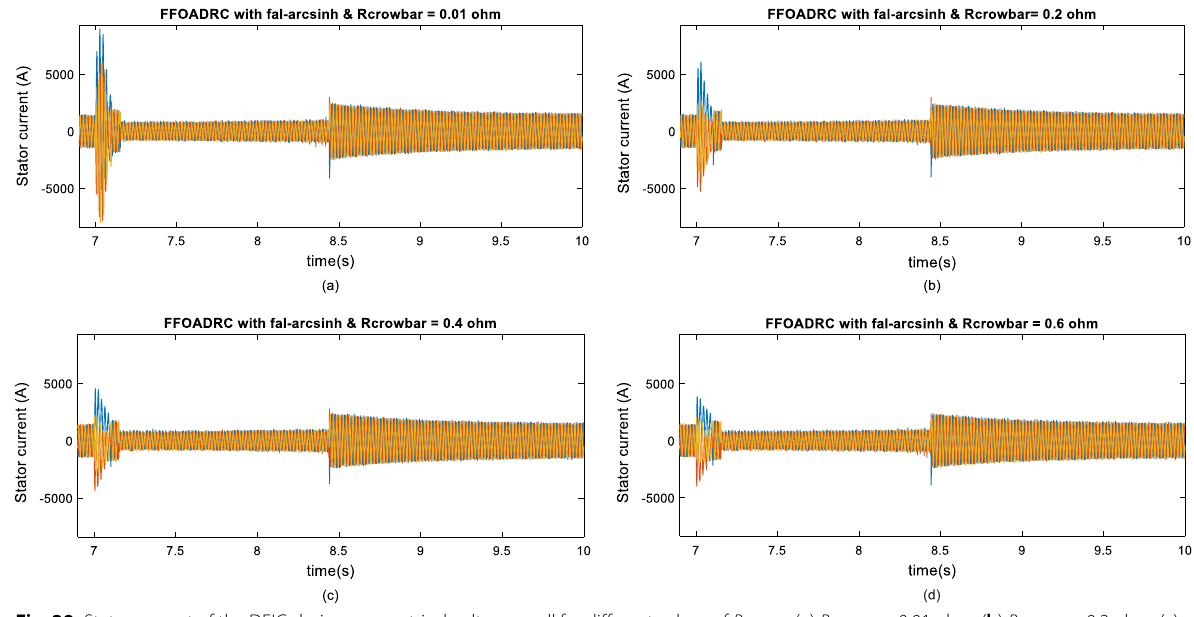
Fig. 29 Stator current of the DFIG during symmetrical voltage swell for different values of R crowbar . ( a ) R crowbar R crowbar 0.4 ohm, and ( d ) R crowbar =